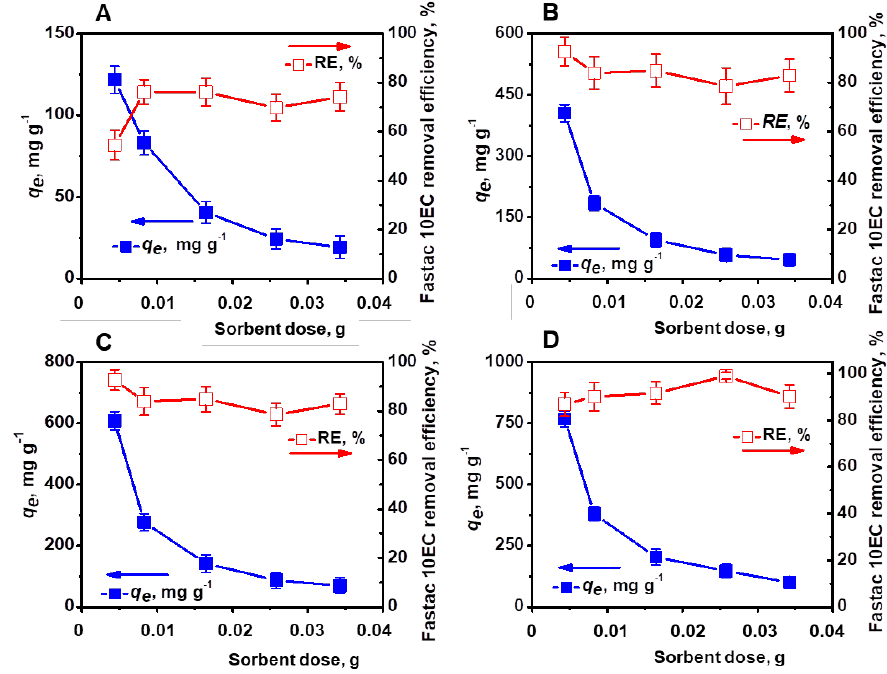
Figure 5. Effect of sorbent dose on the Fastac 10EC removal at various initial concentrations of pesticide: 0.09 mg L −1 ( A ), 0.18 mg L −1 ( B ), 0.27 mg L −1 ( C ), and 0.36 mg L −1 ( D ). Adsorption condi- pesticide: 0.09 mg L − 1 ( A ), 0.18 mg L − 1 ( B ), 0.27 mg L − 1 ( C ), and 0.36 mg L − 1 ( D ). Adsorption tions: pH 6, contact time 24 h, temperature 22 ± 2 °C, and volume of 0.01 L. conditions: pH 6, contact time 24 h, temperature 22 ± 2 ◦ C, and volume of 0.01